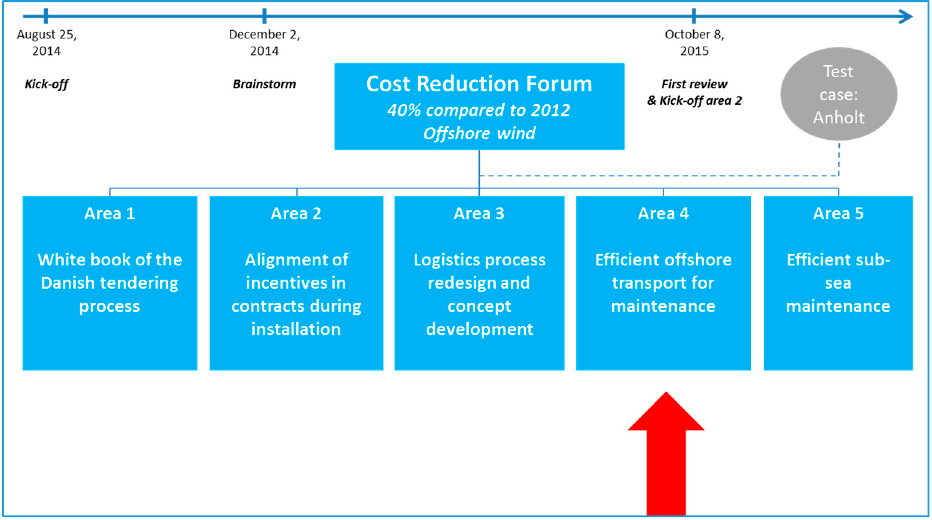
Figure 1. Offshoreenergy.dk Cost Reduction Forum structure including work groups.